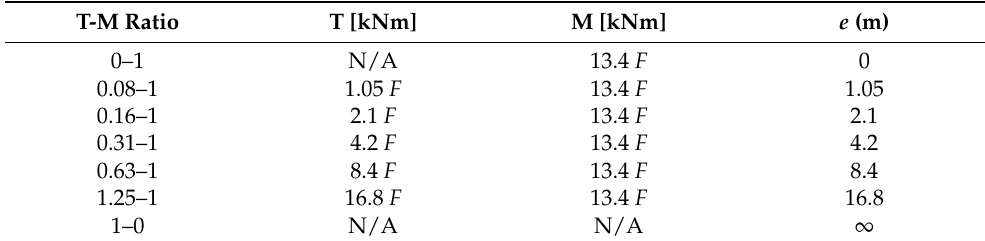
Table 2. Torque-to-bending-moment (T-M) ratios used to load the RC U-shaped core wall structure (where N/A means “not applicable”).